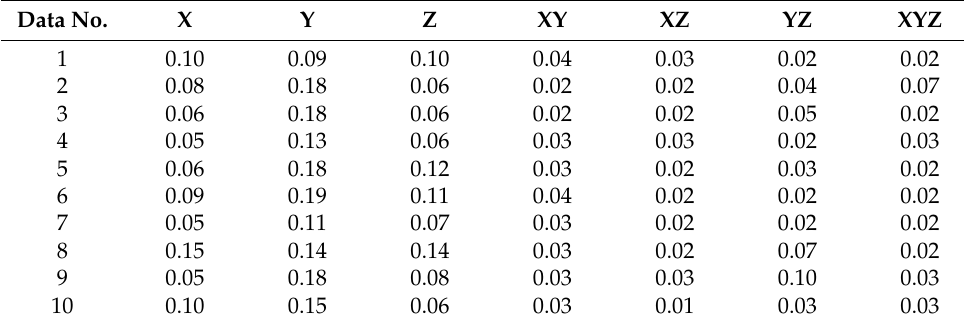
Table 14. CNN summary of ‘loss on test data’. Data